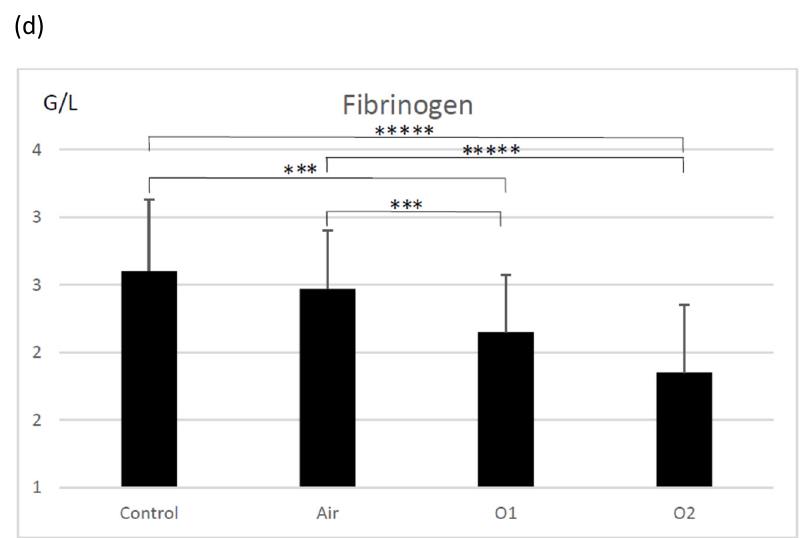
Figure 2. The effect of ozone on D-dimer concentration ( a ), PT—prothrombin time ( b ), APTT— activated thromboplastin time ( c ), and fibrinogen concentration ( d ). Control—the control group ( n = 19); Air—the aerated group ( n = 19); O1—the group treated with ozone at a dose of 15 µ g/mL ( n = 19); O2—the group treated with ozone at a dose of 30 µ g/mL ( n = 19). Mean ± SD, statistically significant difference between the groups (* p < 0.05; ** p < 0.01; *** p < 0.005; **** p < 0.0005; ***** p <